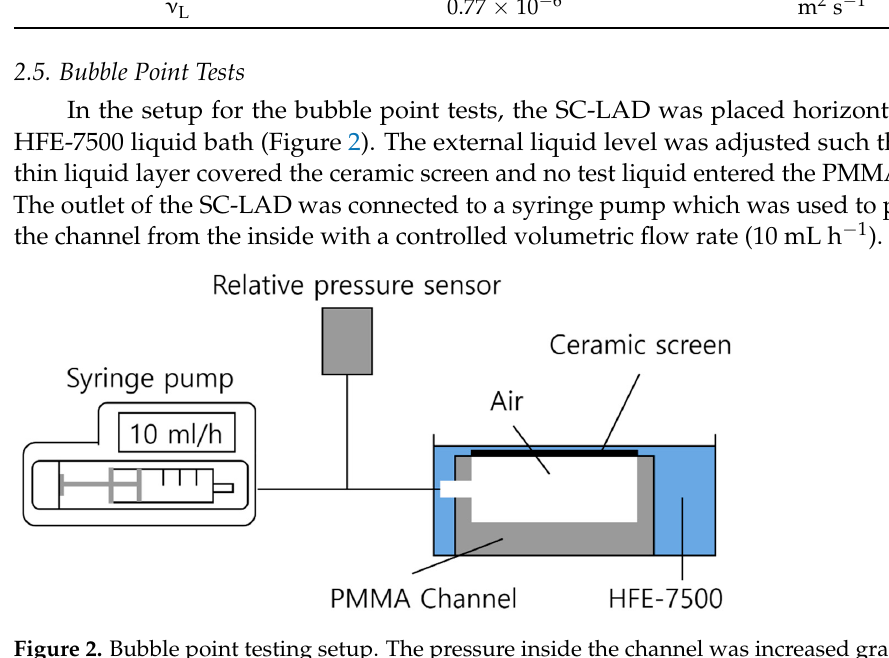
Figure 2. Bubble point testing setup. The pressure inside the channel was increased gradually in a controlled manner by injecting air into the channel with the help of a syringe pump until the bubble breakthrough happened.